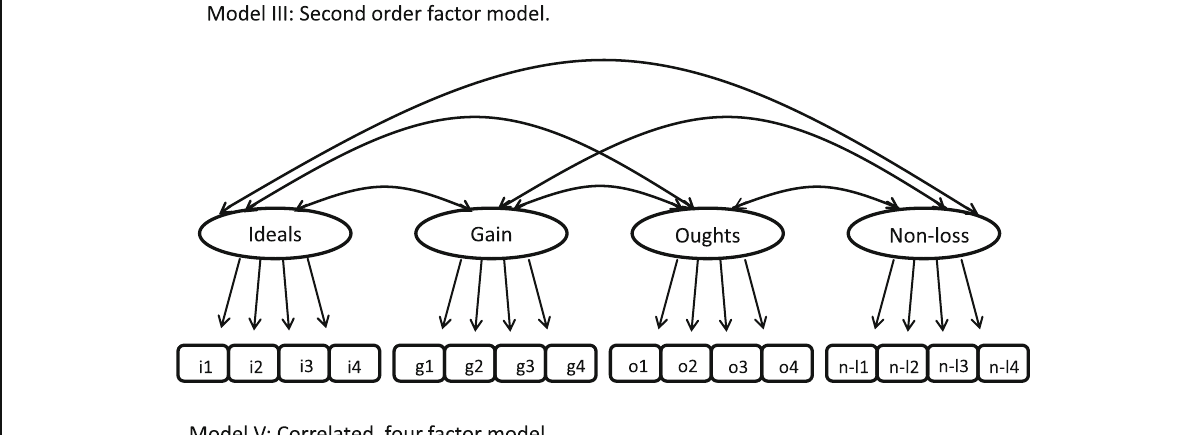
Fig. 1 Measurement models of the Momentary-Chronic RF scales (models III and V depicted without